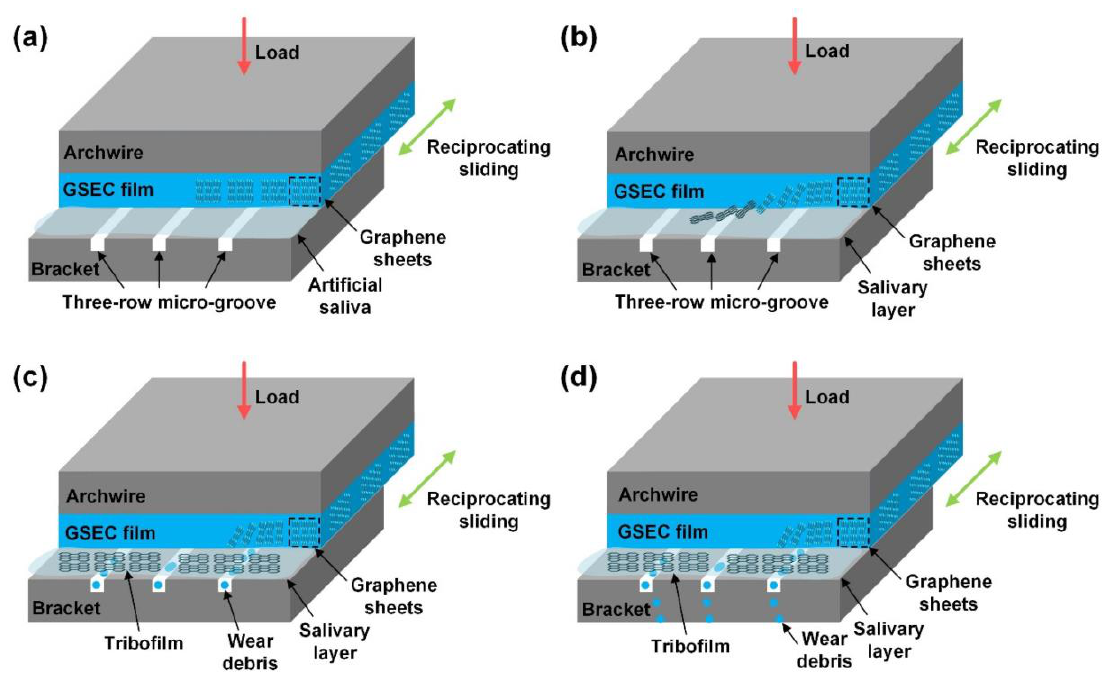
Figure 4. The low-friction and low-wear mechanisms of the GSEC-film-coated stainless steel arch- wires running against three-row microgroove-textured stainless steel brackets in an artificial saliva environment. ( a ) Initial state of the contact combination, ( b ) stable low friction with the formation of graphene-rich tribofilm and salivary adsorbed layer, ( c ) accumulation of wear debris detached from the GSEC film with microgroove, and ( d ) flow out of wear debris with artificial saliva from the microgroove. Adapted with permission from [46].